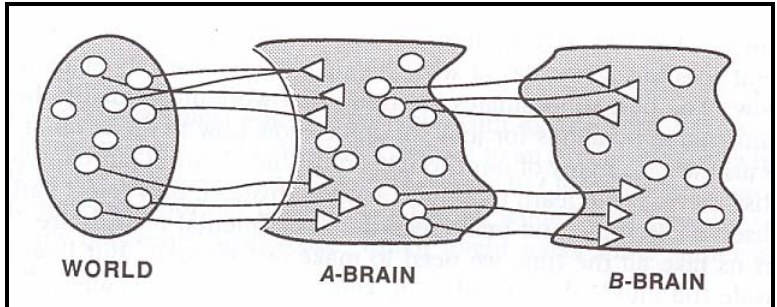
Figure 2. Minsky’s A-Brain and B-Brain (Minsky,